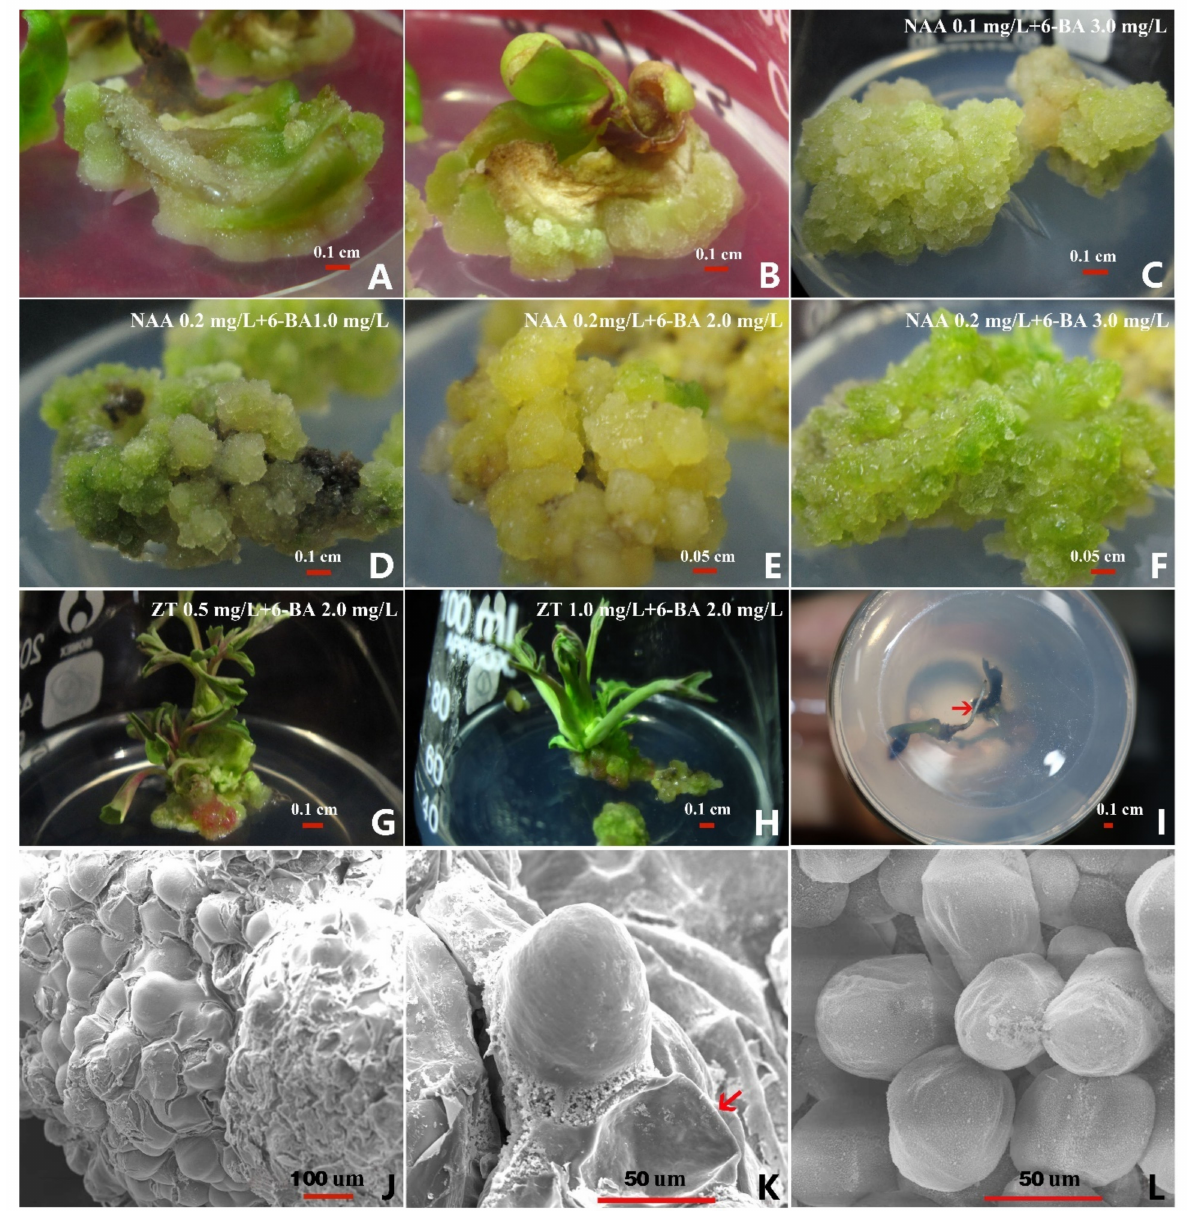
Figure 1. ( A ) A callus from petals (white, compact, granular). ( B ) A growing callus (white, compact, granular). ( C – F ) The proliferation of calluses on different media (the characteristics of the calluses were light-yellow, loose, granular; yellow-green, loose, granular; yellow, compact, clumpy; light- green, loose, granular). ( G , H ) Shoot formation from calluses on different media. ( I ) Root formation of plants (the red arrows represent the growing root). ( J , K ) The surface of a callus on a medium of MS + 1.0 mg/L 6-BA (the protrusions had a loose arrangement and the bottom of the protrusions was cracked; the red arrow indicates the concave protrusion surface). ( L ) The surface of a callus on a medium of MS + 0.5 mg/L ZT + 2.0 mg/L 6-BA (the protrusions were closely